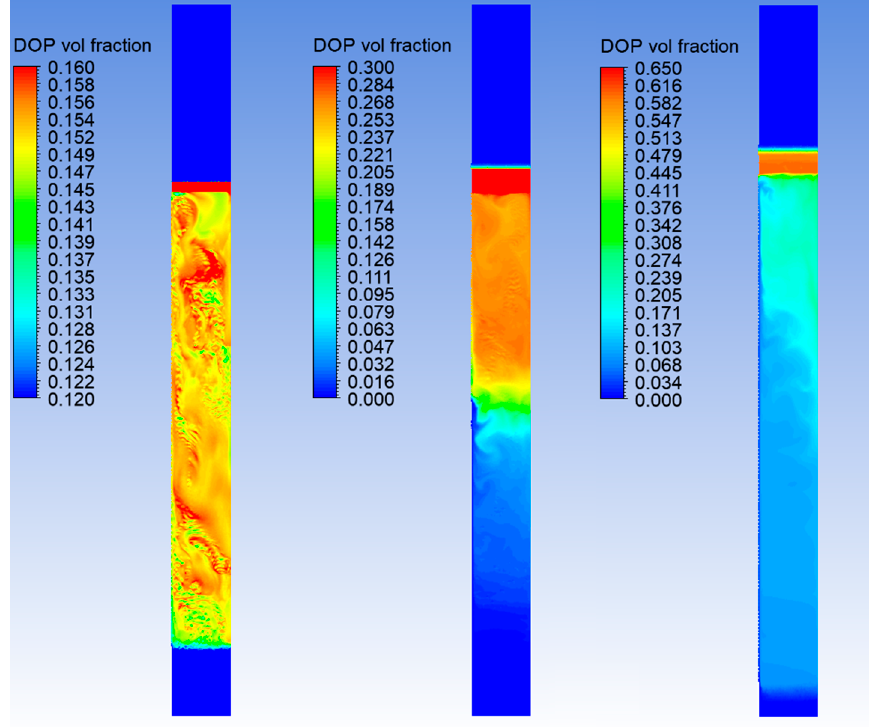
Figure 5. Volume fraction distribution of DOP within the reactor at different times, for the case of power input of 4.0 kW. From left to the right: 2, 20 and 40 min after the start of the process.